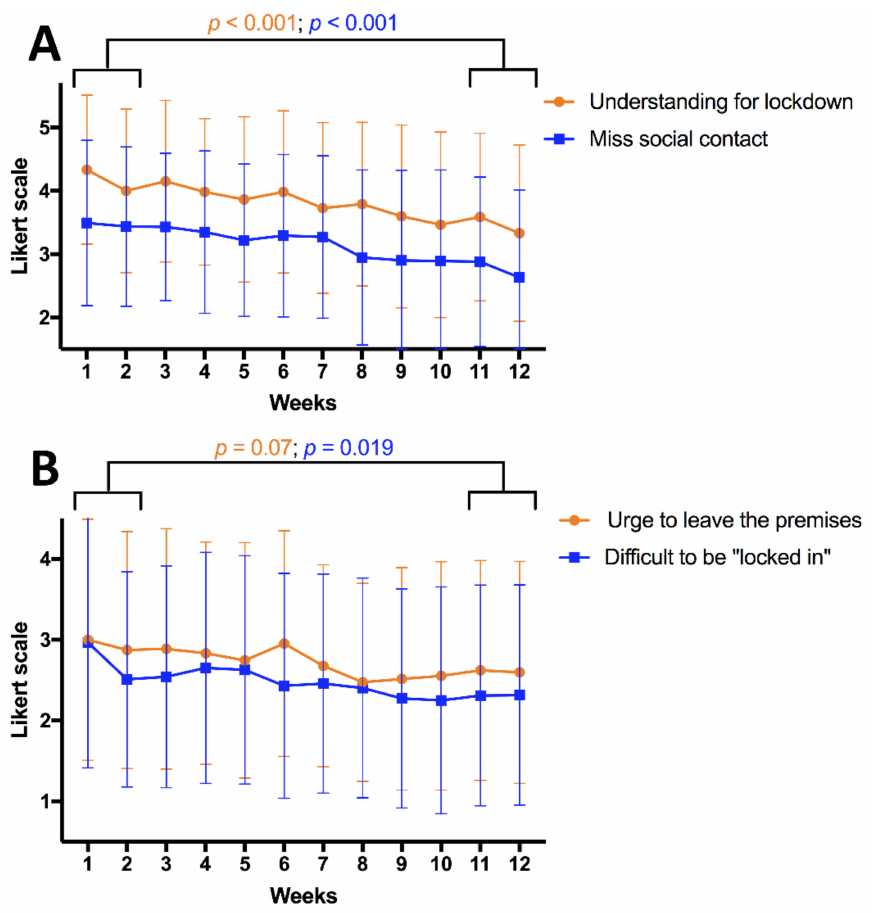
Figure 4. Changes in perception of the isolation over the course of the twelve-week study period. Answers correspond to items 2 and 3 ( A ) and 17 and 5 ( B ) from the ISOLA questionnaire, respectively. Data are presented as mean and standard deviation. Statistical comparisons were made between the first and last two weeks using the Mann–Whitney U test. Results are demonstrated for all participants ( n = 100) and any participant who completed a questionnaire at the relevant timepoint was included. A graph depicting results for patients and relatives separately can be found in Figure